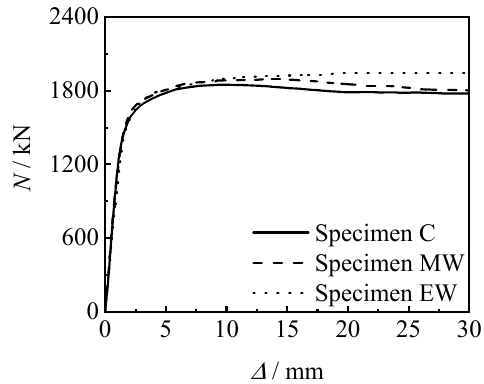
Figure 9. N - Δ curves of specimens without thread. Figure 9. N - ∆ curves of specimens without